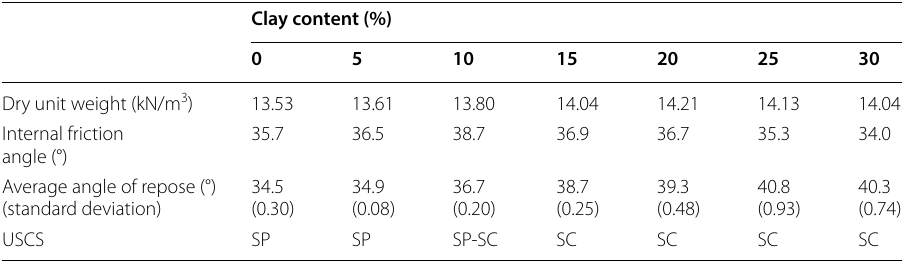
Table 2 Friction angle measurements and soil classifications of clay–sand mixtures with different clay